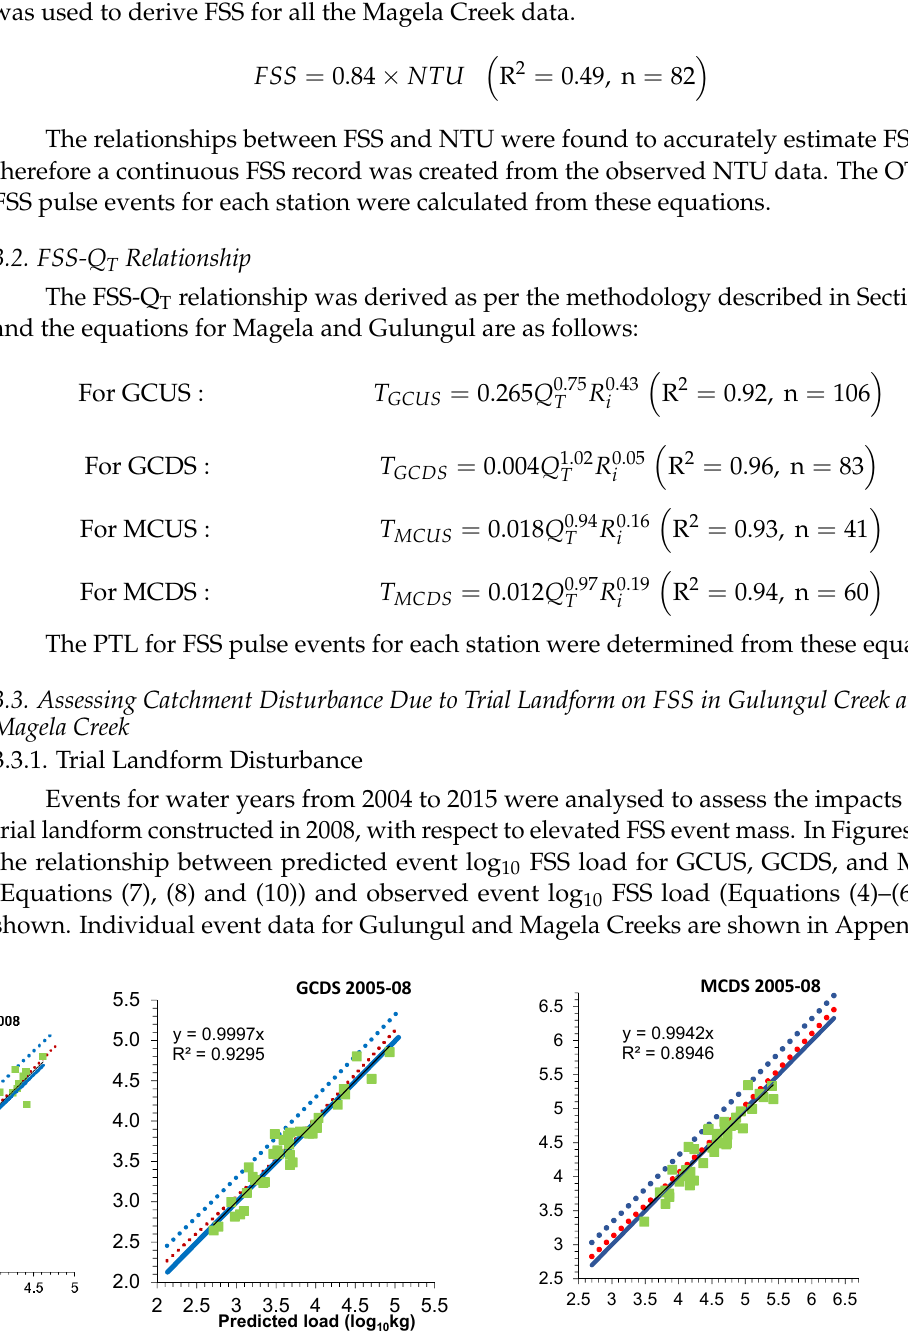
( c ) Figure 8. Relationship between OTL and PTL at GCUS ( a ), GCDS ( b ), and MCDS ( c ) (2008–2009). See Figure 7 for the ex- planation of the lines and colors of the points.